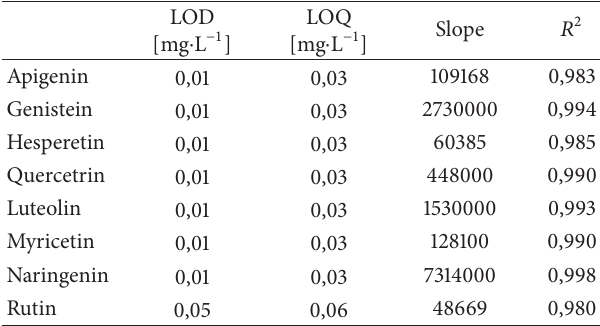
Table 2: Validation parameters for flavonoids analysis. Conditions with ACN/ammonium formate as an